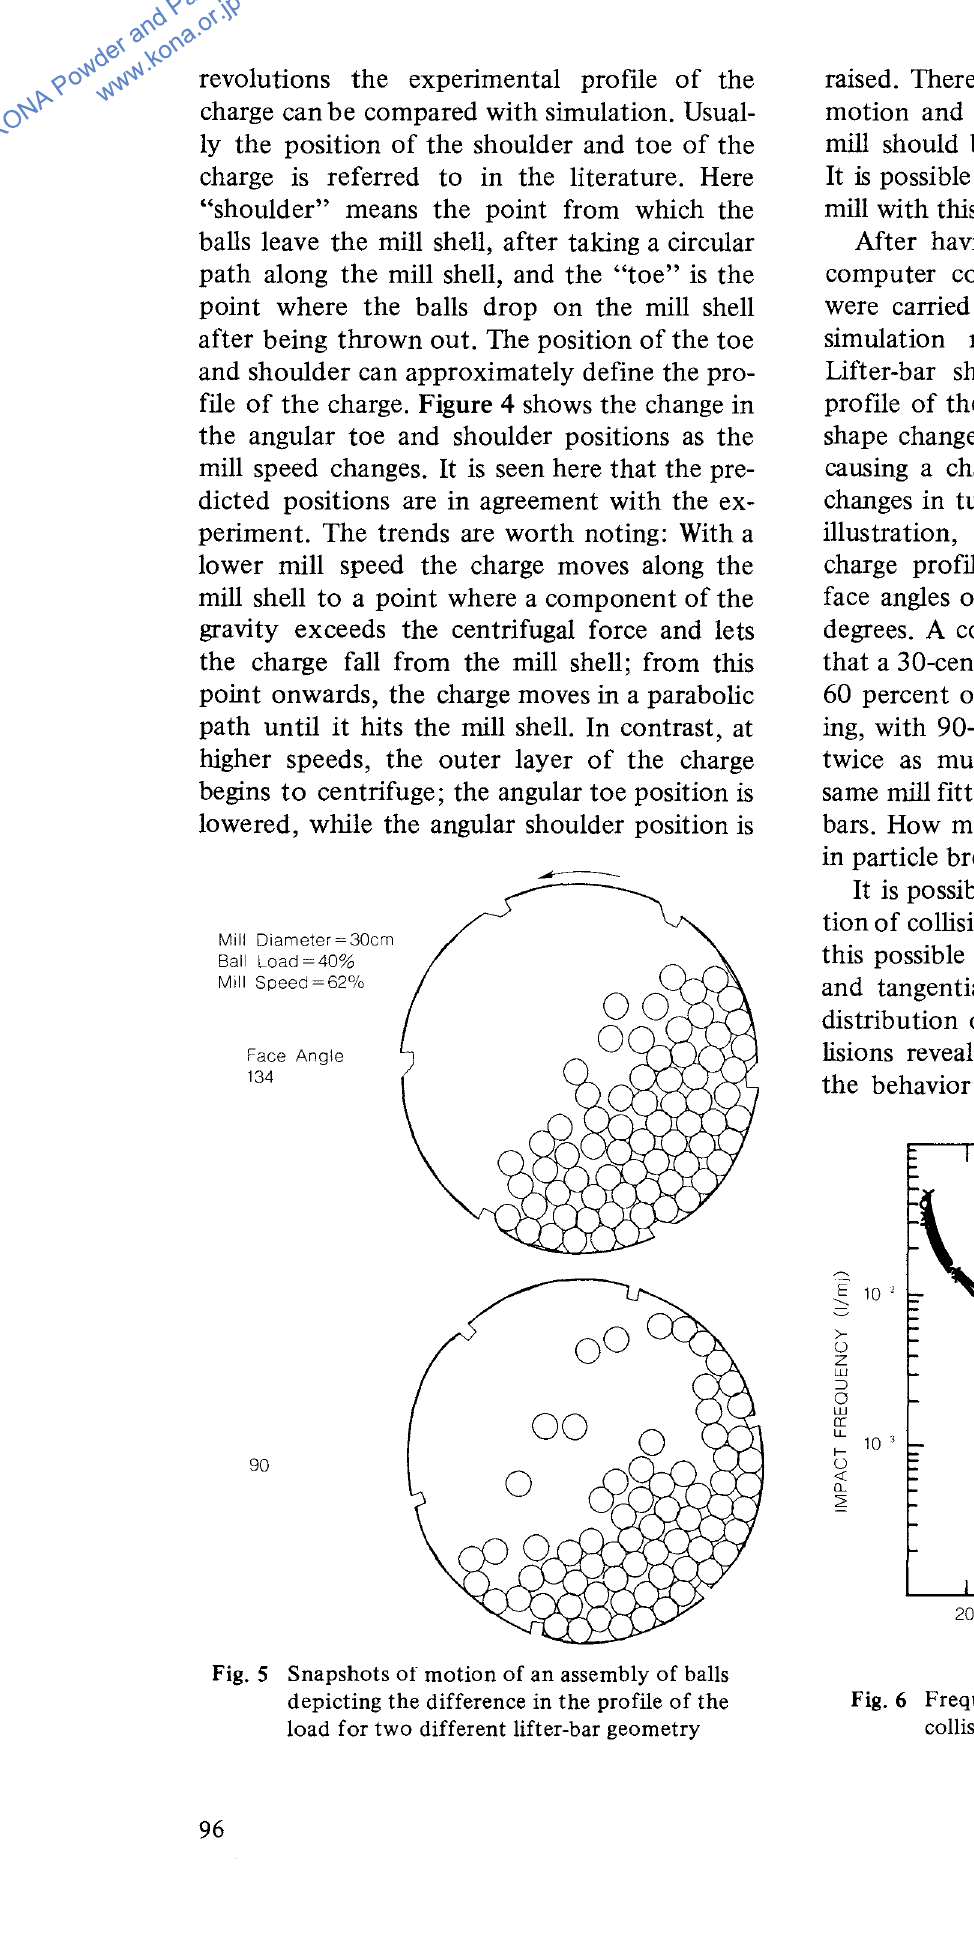
Fig. 5 Snapshots or motion of an assembly of balls depicting the difference in the profile of the load for two different lifter-bar geometry